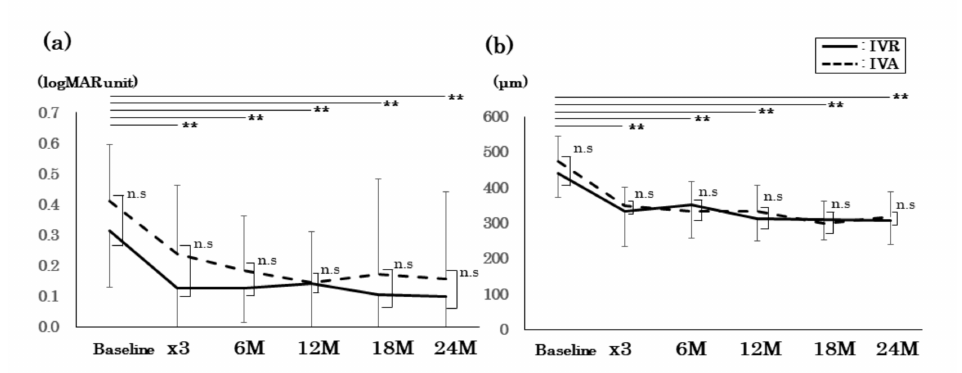
Figure 3. Changes in best-corrected visual acuity (BCVA, ( a )) and central retinal thickness (CRT, ( b )) following an intravitreal injection of ranibizumab (IVR) and aflibercept (IVA) applied with the treat-and-extend regimen. Two-way repeated-measures ANOVA and posthoc t -tests with Bonferroni’s corrections were used to determine the significance of the changes in BCVA and CRT. Kolmogorov–Smirnov tests were used to determine the significance of the di ff erences between IVR and IVA. ** p < 0.01. Black line, IVR; broken line, IVA; n.s: no